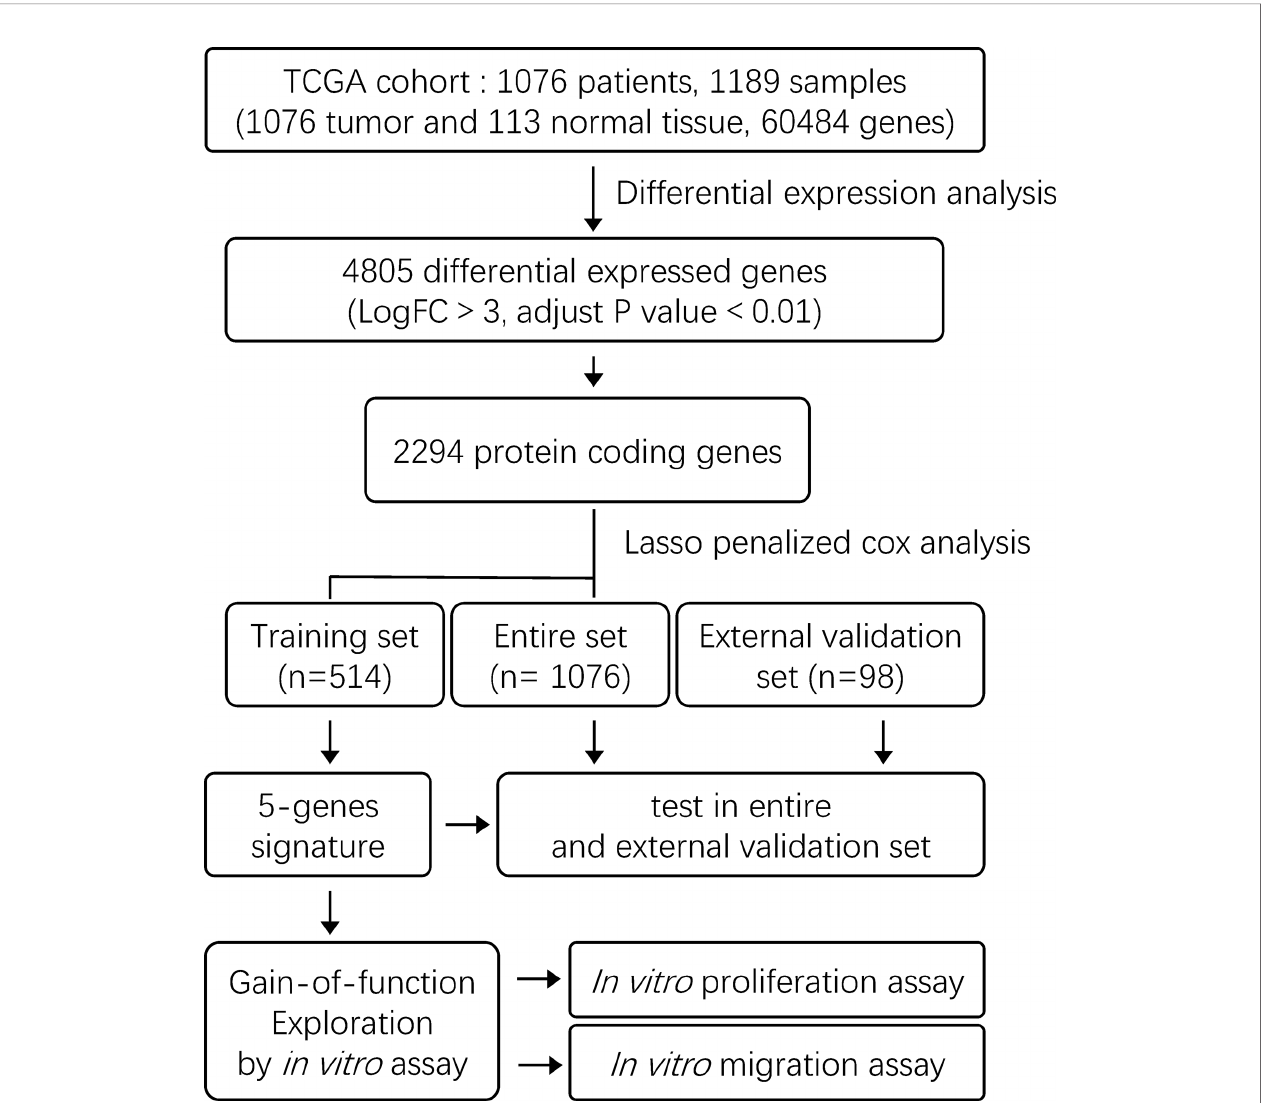
FIGURE 1 | The fl ow chart showing the scheme of the study on fi ve-gene prognostic signatures for breast